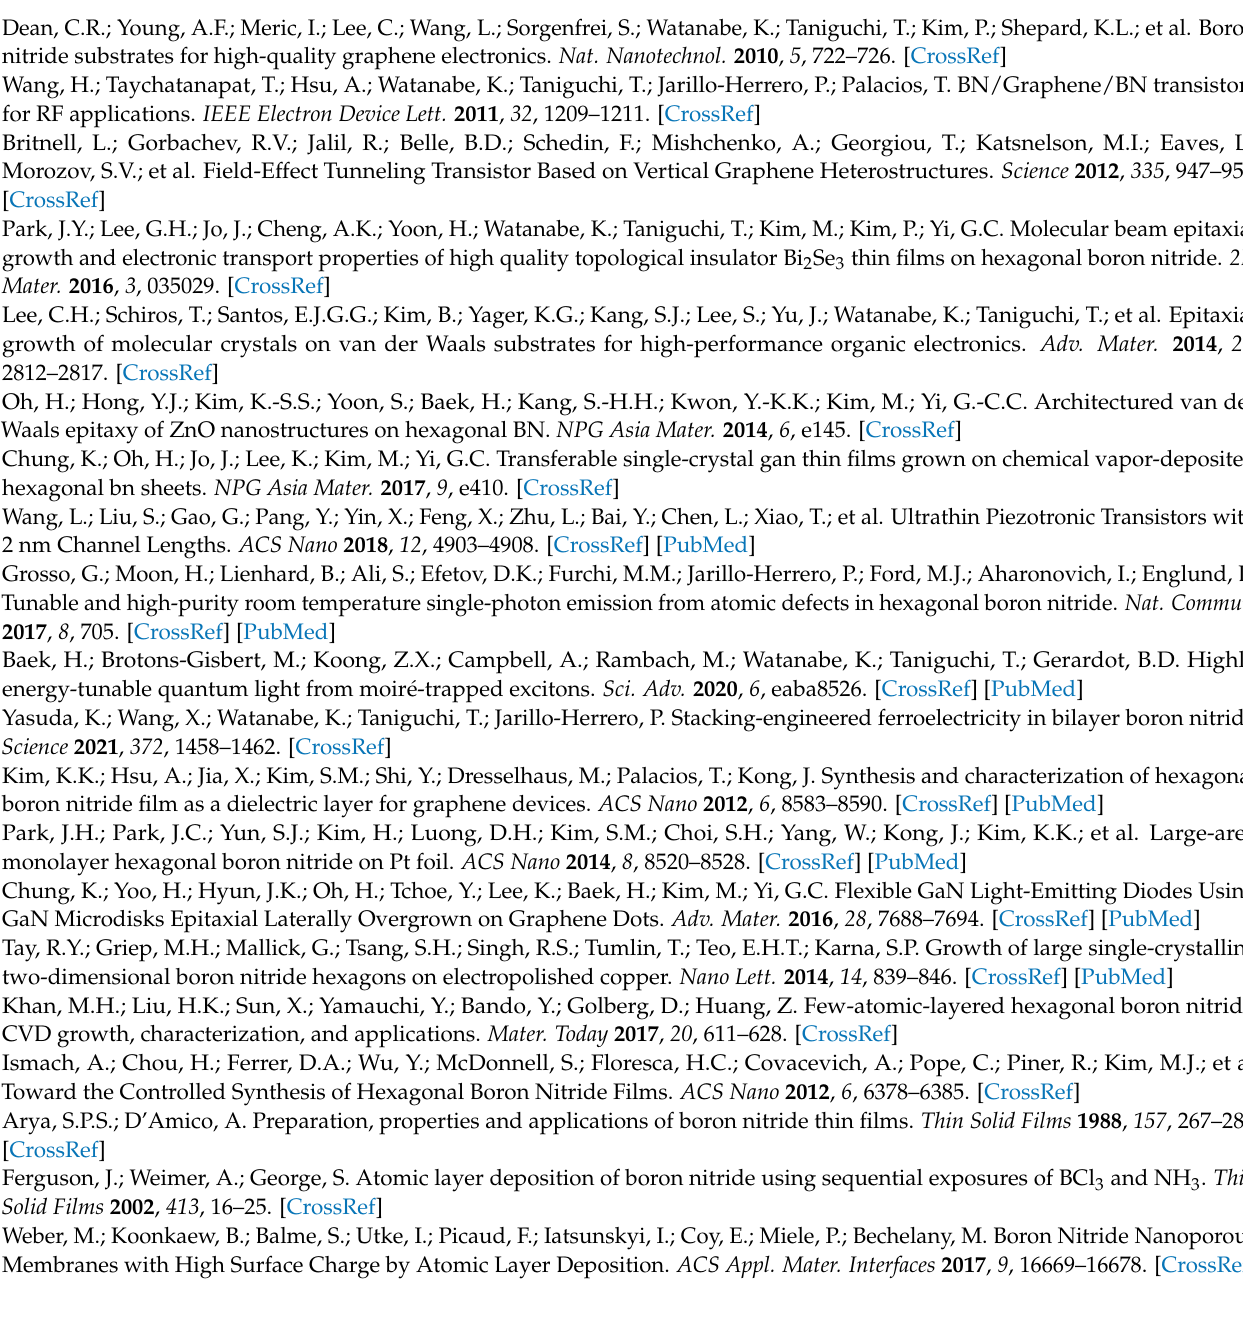
Figure A2. HR-TEM images of h-BN films with accidentally folded regions, captured from different spots. The film was grown at 1000 °C for 15 cycles. Approximate numbers of layers are ( a ) 4 layers, ( b ) 5 layers, and ( c ) 5 layers. Scale bar: 2 nm.